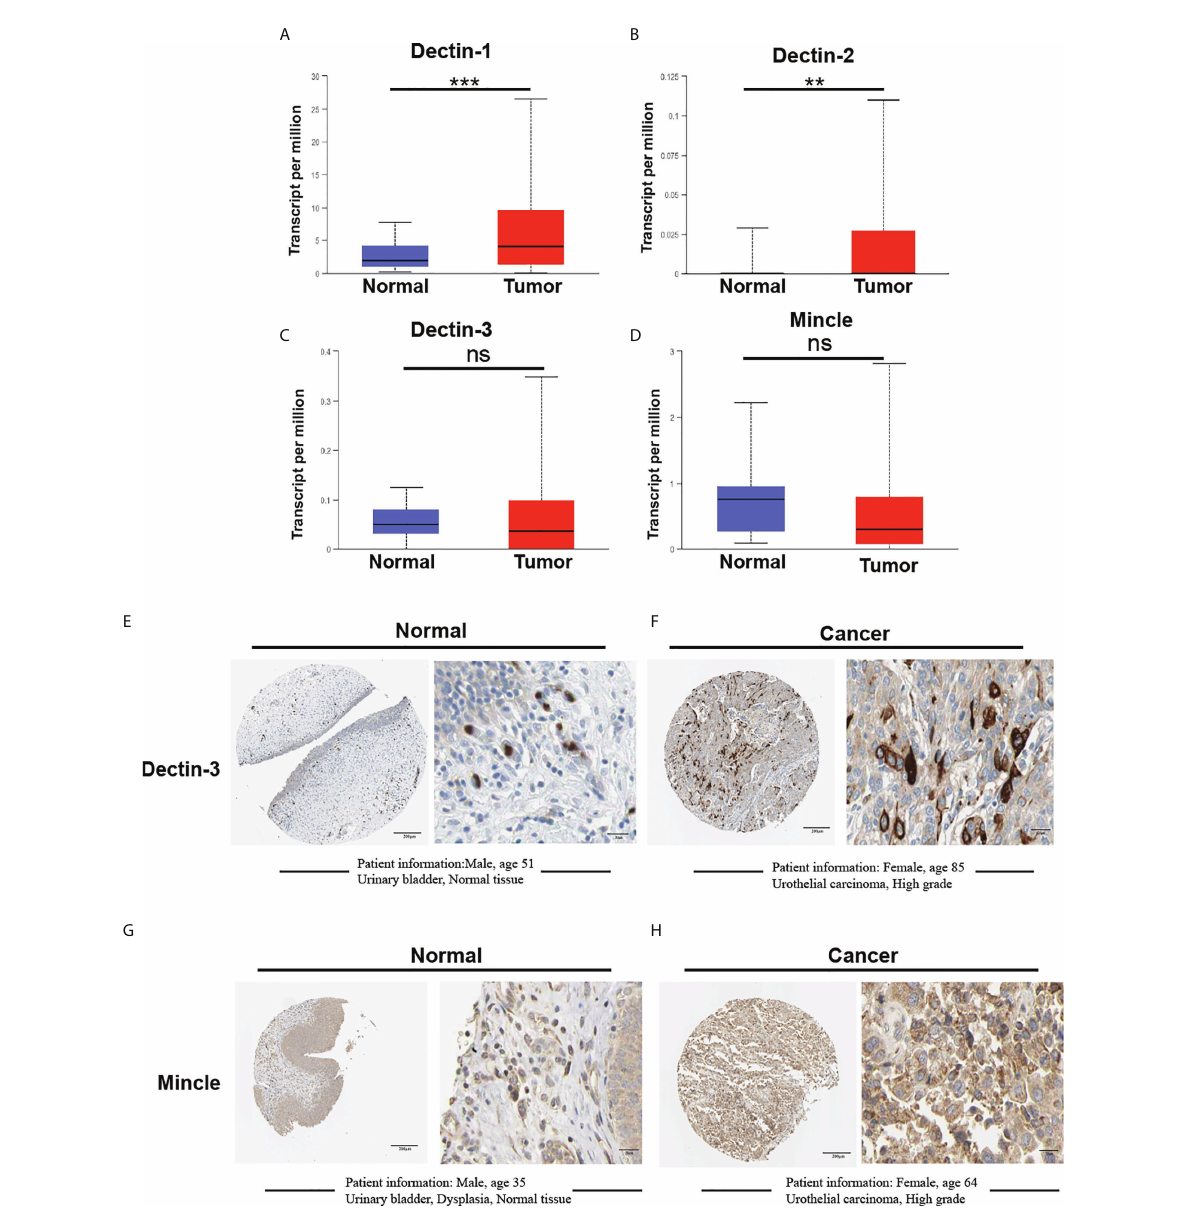
FIGURE 2 Comparative analysis of mRNA expression of CLRs between bladder cancer tumor tissue and normal bladder tissues using the Cancer Genome Atlas. (TCGA; https://portal.gdc.cancer.gov) database (A – D) . The TCGA database is part of a landmark cancer genomics program that has characterized over 20,000 primary cancers of 33 types and corresponding normal tissue samples. Our analysis enrolled 19 normal tissues and 408 tumor tissues from the bladder cancer database. IHC results show the protein expression of Dectin-3 and Mincle in normal bladder tissues (E, G) and bladder cancer tumor tissues (F, H) . The basic clinical information of the enrolled patients is presented. ns means no signi fi cant difference was found between the two groups.**p < 0.01,***p <